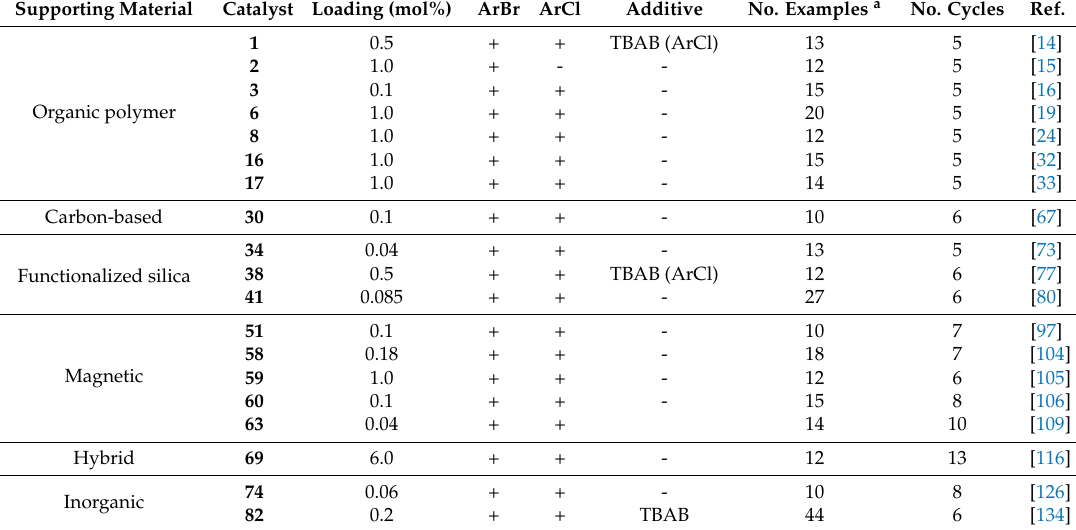
Table 1. Selected supported catalysts working with aryl bromides and/or chlorides in the Sonogashira reaction. Only catalysts used in 10 or more reactions involving aryl bromides and chlorides and employed in five or more reaction cycles are